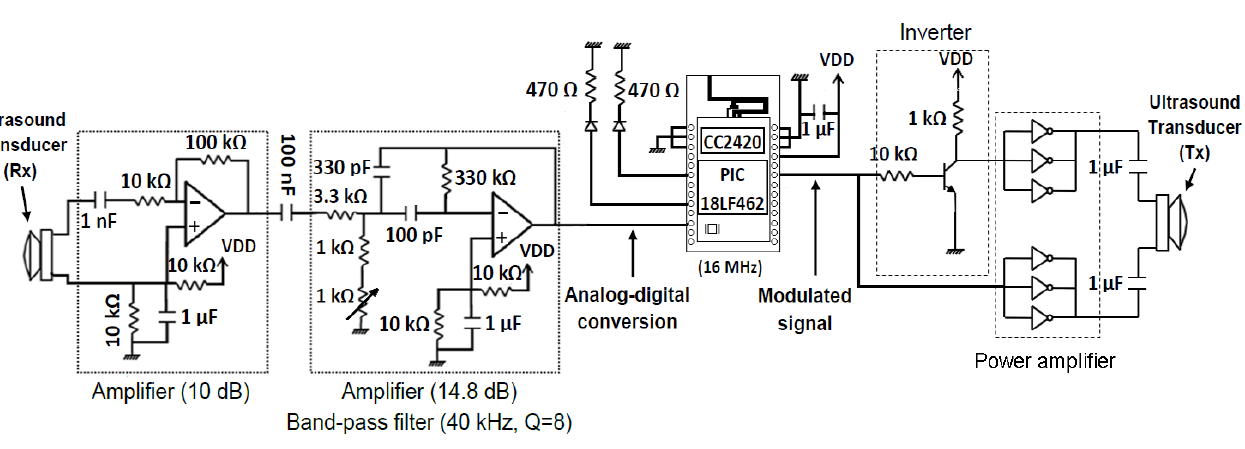
Figure 3. Picture of a TELIAMADE node. The regions identified by dashed line